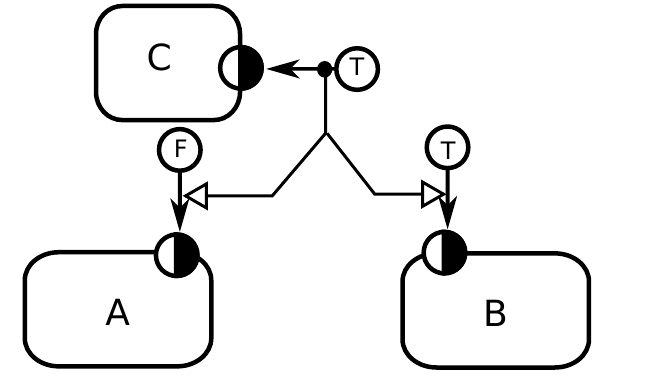
Figure 2.45: The reaction from Figure 2.43 on the preceding page in Entity